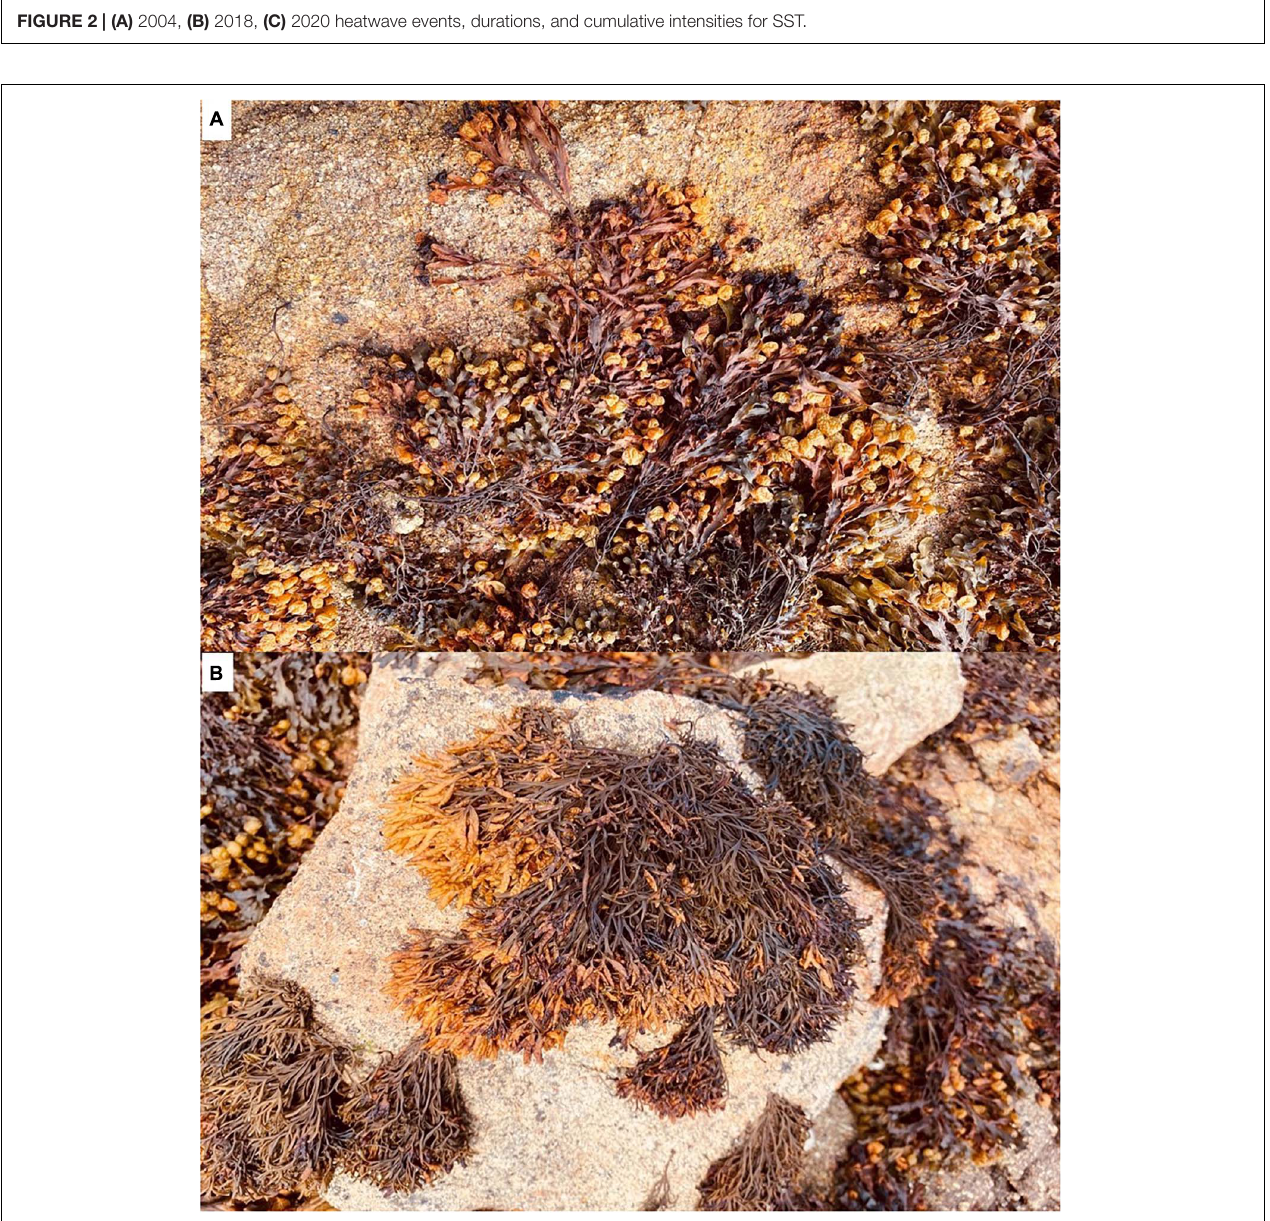
Frontiers in Marine Science |